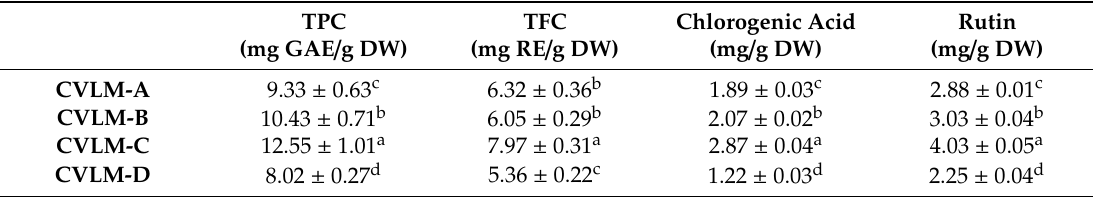
Table 1. TPC, TFC and major individual phenolic compounds in CVLMs from the leaves of C. violaceum collected from di ff erent